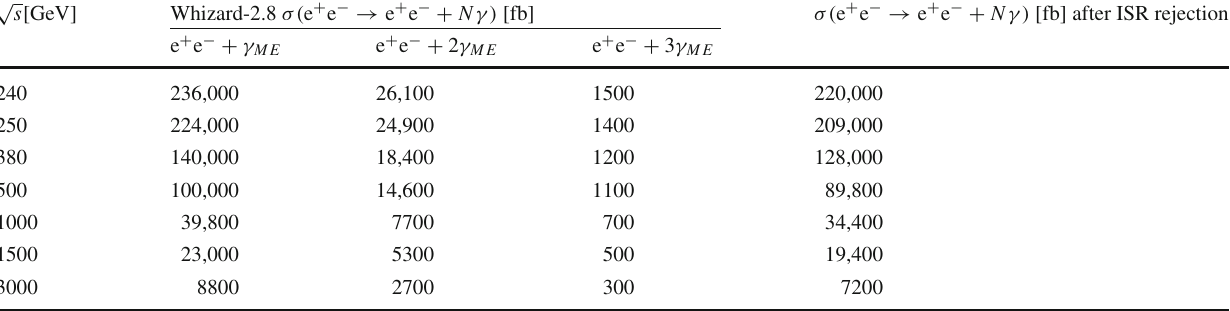
Table 5 Cross section values for different collision energies and different multiplicities of photons included in matrix element calculations in Bhabha events with a requirement of at least one of the matrix elements photons to be ’hard’. Number of significant digits indicates the statistical precision resulting from Whizard integration √